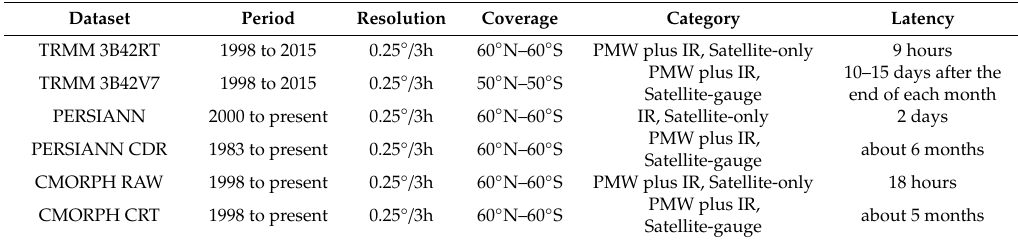
Table 1. Summary of the six satellite-based precipitation products (SPPs) used in this study. Dataset Period Resolution Coverage Category TRMM